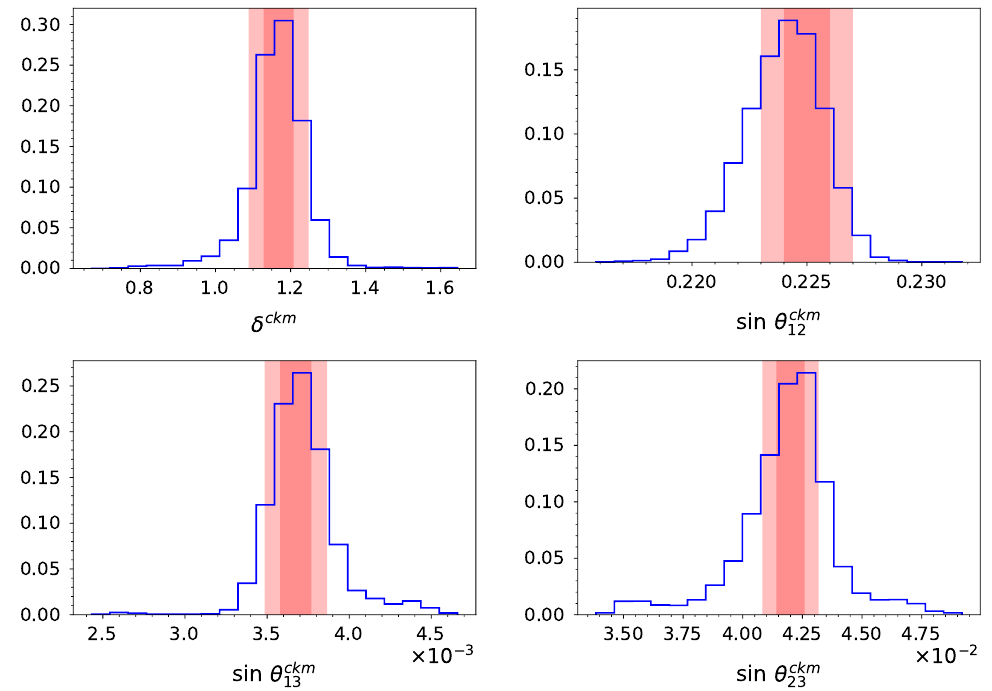
Figure 6 . The CKM parameters are displayed where the red (light red) region indicating the 1 σ ( 2 σ ) limits. All parameters in the CKM are fitted very well with an approximately Gaussian distribution around the expected